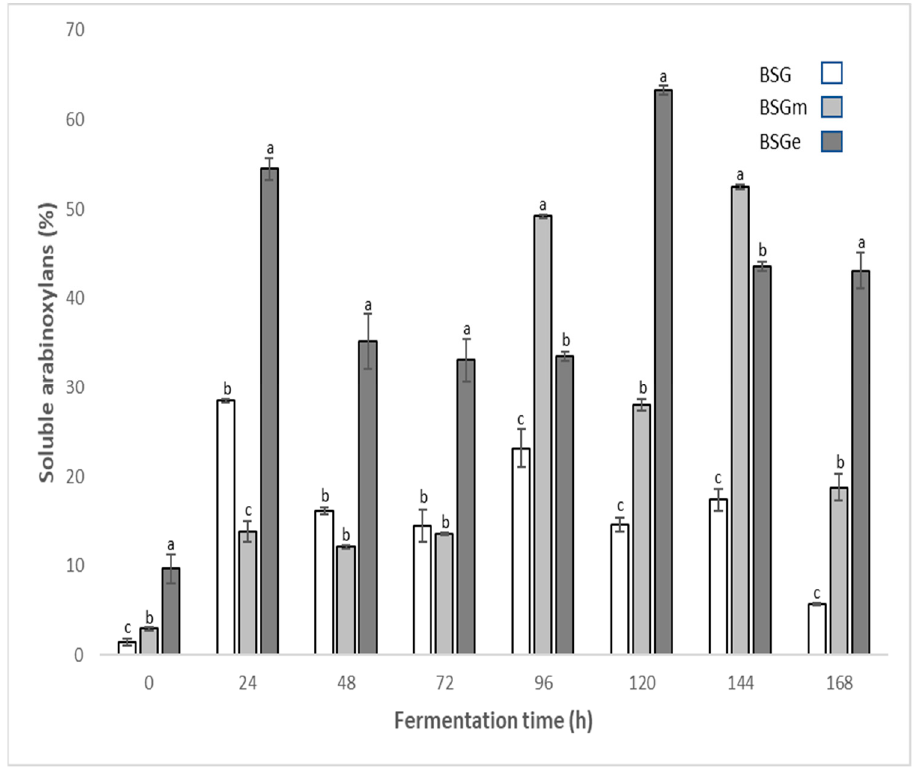
Figure 1. Content of soluble arabinoxylans in extracts of brewers’ spent grain (BSG), BSG milled (BSGm), and BSG extruded (BSGe), and the fermented counterparts by Fusarium oxysporum up to 168 h. Significant differences for each fermentation time are shown by the letters a, b, and c.